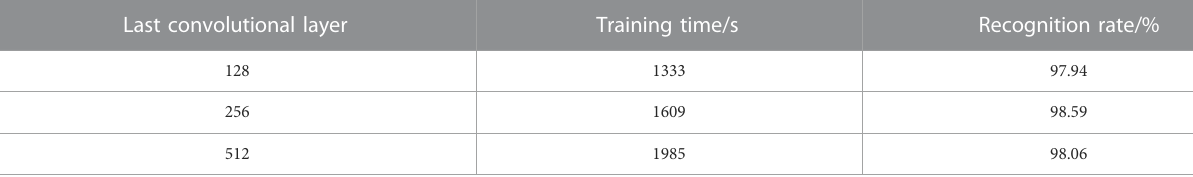
TABLE 3 Comparison of the number of neurons in the last convolution layer. Last convolutional layer